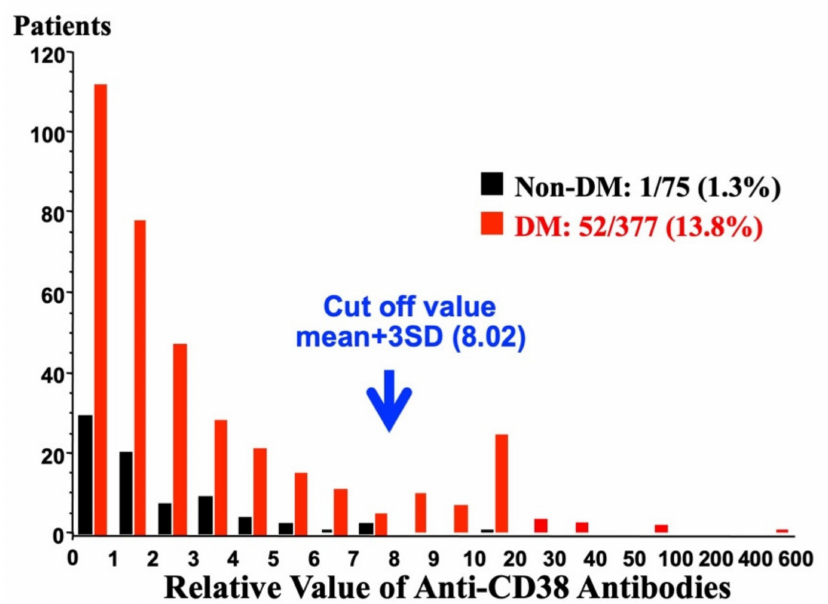
Figure 7. Distribution of relative values of anti-CD38 autoantibodies in 377 Japanese diabetic patients (adapted from [30]). The relative levels of CD38 antibodies are expressed as an index value relative to a standard non-diabetic serum. Values above the mean + 3 SD of the control samples (non-DM) were regarded as antibody positive. The arrow indicates a mean + 3 SD of non-diabetic control. Anti-CD38 positive patients were observed in diabetic